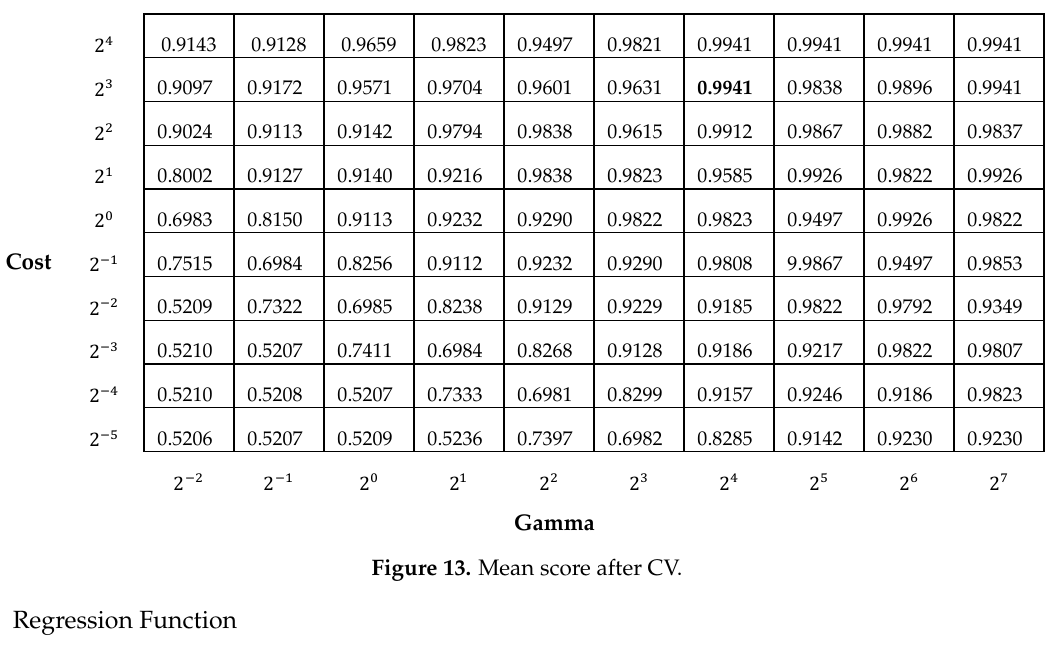
Figure 12. The mean and standard deviation of positioning errors vs. number of nearest neighbors by: ( a ) whole floor, ( b ) center area, and ( c ) edge area.